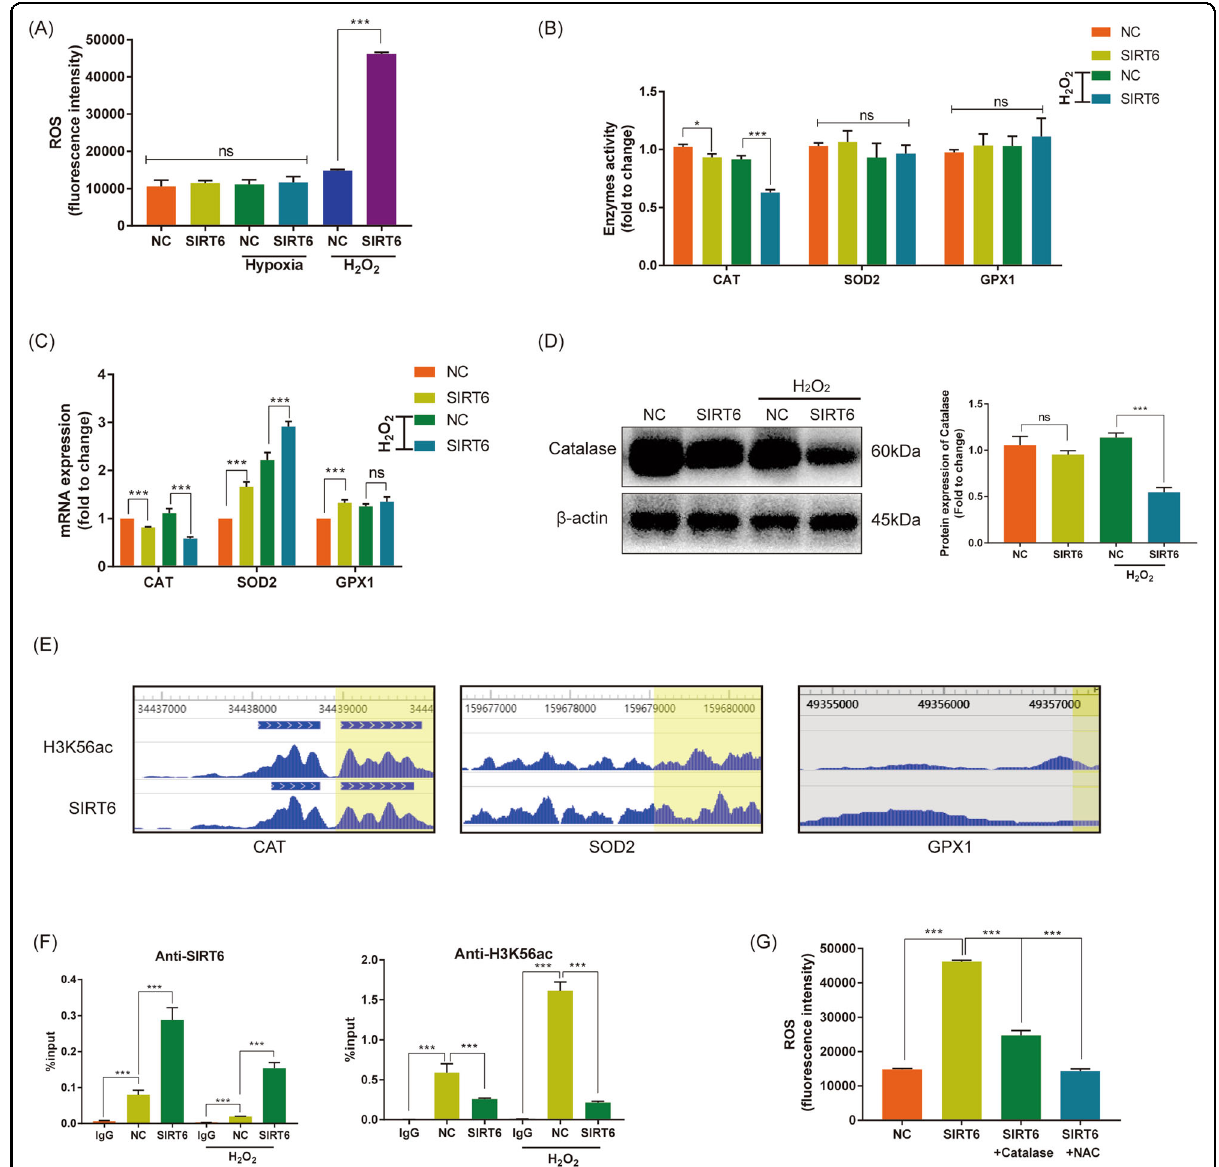
Fig. 6 SIRT6 promoted reactive oxygen species via H3K56ac of Catalase in HUVECs under oxidative stress. A ROS of HUVECs-NC and HUVECs- SIRT6 under normoxia (normal group), hypoxia, and oxidative stress (treated with 1 mM H 2 O 2 for 3 h). B The enzyme activity of three main ROS scavengers: Catalase (CAT), superoxide dismutase (SOD2), and glutathione peroxidase (GPX1), with or without H 2 O 2 treatment. C The mRNA expression of CAT, SOD2, and GPX1, with or without H 2 O 2 treatment. D Protein expression of Catalase with or without H 2 O 2 treatment performed by western blotting. E SIRT6 and H3K56ac enrichment at the promoter of CAT , SOD2 , and GPX1 detected in CHIP-sequence datasets GSE102813. F CHIP analysis of HUVECs-NC and HUVECs-SIRT6 using IgG, anti-SIRT6, and anti-H3K56ac, respectively. G Transfection of pcDNA3.1-Catalase and treatment of N-acetyl-L-cysteine (NAC, 5 mM for 3 h) rescued increased ROS in HUVECs-SIRT6 (ns: no signi fi cance, ** P < 0.01, *** P <